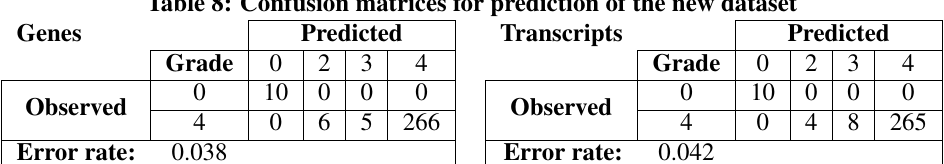
Table 8: Confusion matrices for prediction of the new